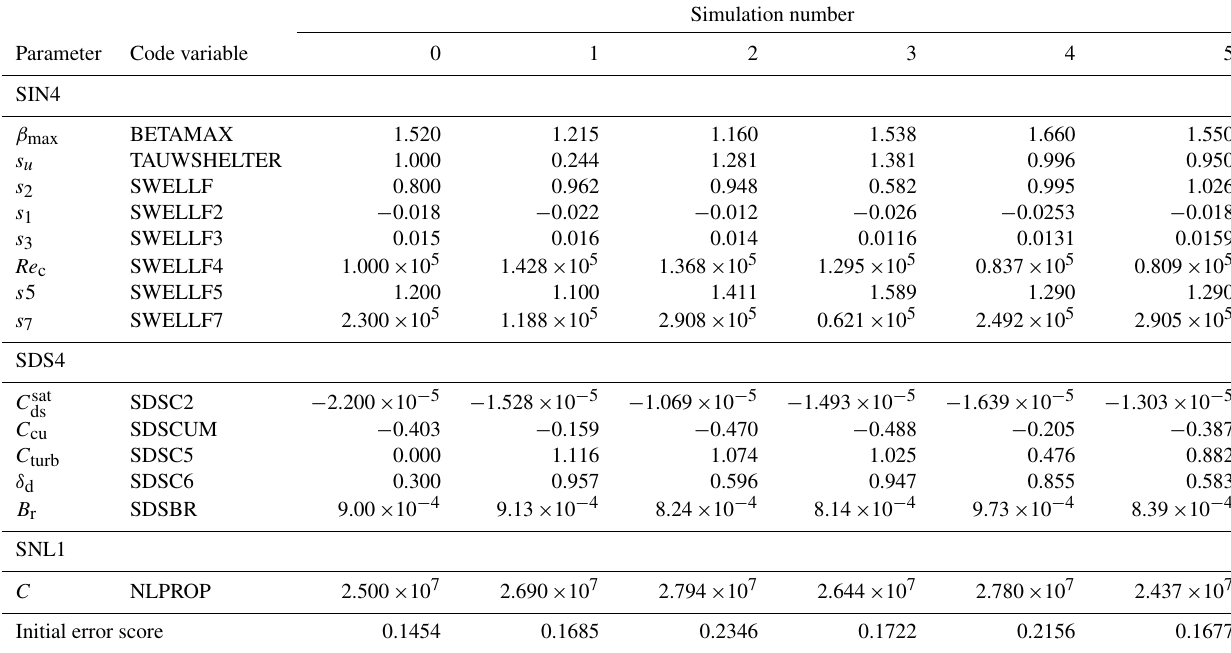
Table 4. Initial parameters used to calibrate the simulations using the source term package of Ardhuin et al. (2010), for February 1997, using randomised initial conditions (simulations 1–5). Simulation 0 is the control case, with default initial parameters.